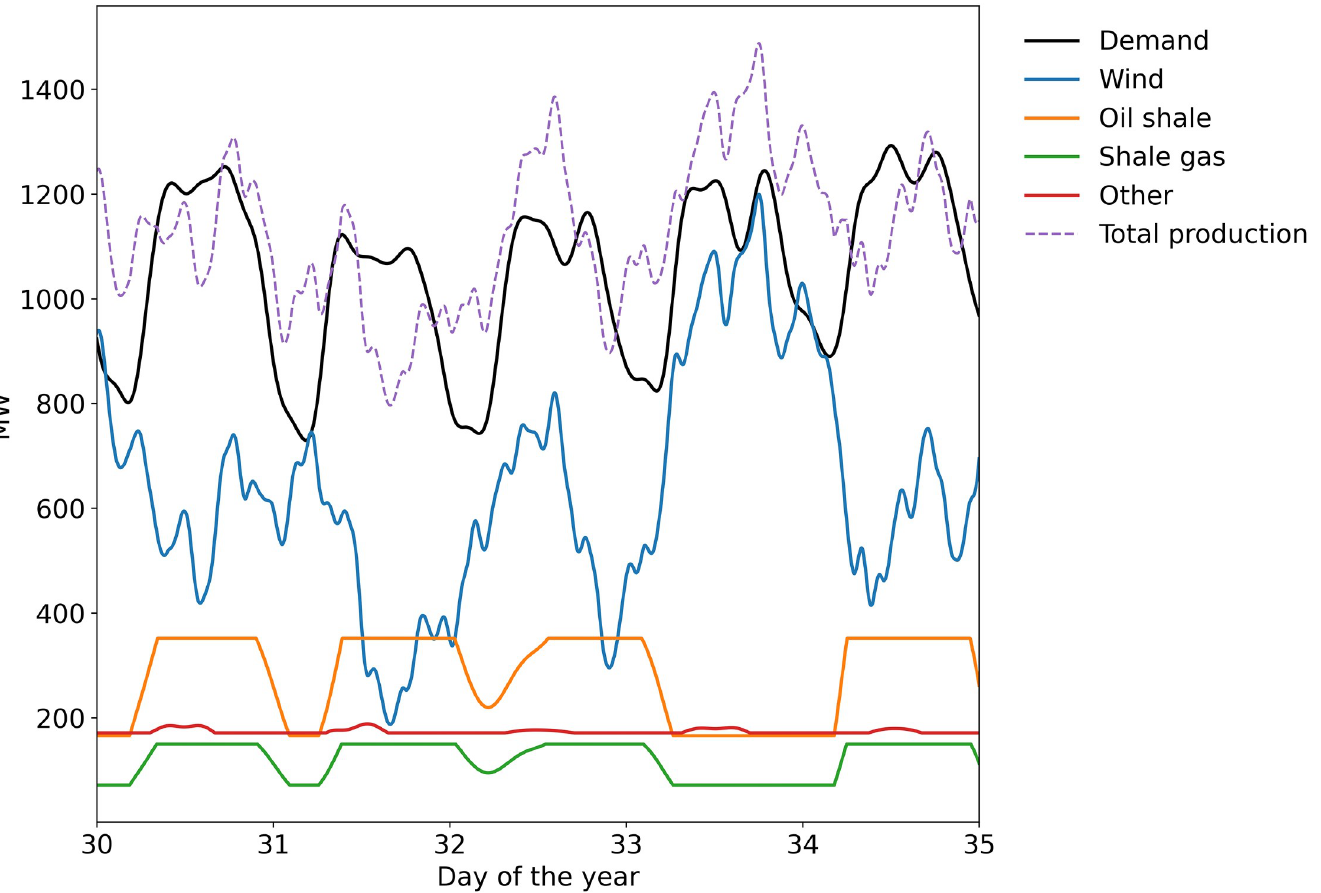
Fig 1. Example of data from a simulation for electricity demand and production in